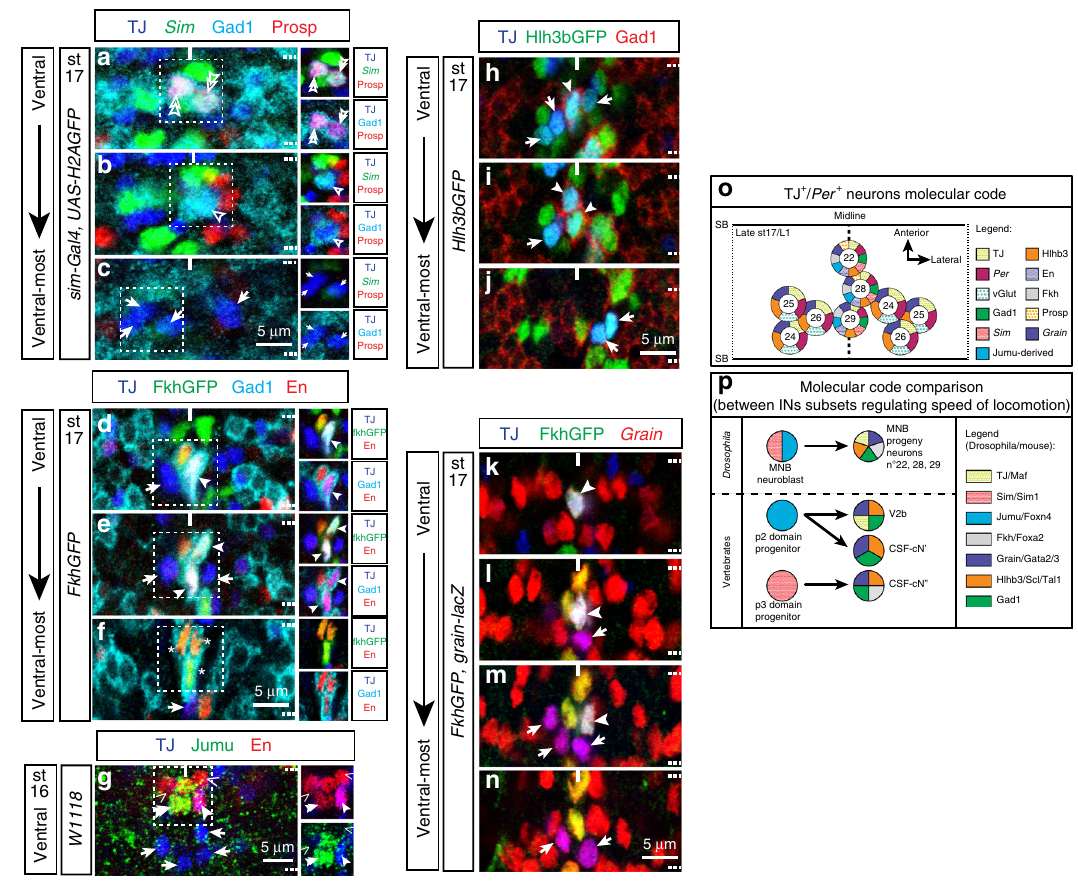
Fig. 9 Molecular characterization of the three TJ + / Per + GABAergic neurons. a – c Staining for TJ (blue), Gad1 (cyan), Prospero (Prosp, red), and GFP (green) driven by sim-Gal4 in late stage 17 embryonic VNC. a , b sim-Gal4 (green) is weakly expressed in ventral TJ + GABAergic + neurons, identifying them as midline cells (simple and double empty arrowheads). c TJ + GABAergic − ventral-most neurons (which are TJ + glutamatergic neurons, pointed by arrows) are sim-Gal4 − , hence not part of the midline cells. Among the three TJ + / sim + weak /GABAergic + located at the midline, two are positive for Prospero ( a double empty arrowheads) and one negative ( b simple empty arrowhead). d – f Staining for TJ (blue), Gad1 (cyan), Engrailed (En, red), and FkhGFP in stage 17 embryonic VNC. Ventrally, TJ + /GABAergic + neurons (full arrowheads) are En + and Fkh + , two markers of MNB progeny neurons. Note in the ventral-most part of the VNC the three iVUMs cells En + /Fkh + /Gad1 + that are TJ − (asterisks in panel f ). g Staining for TJ (blue), Jumu (green), and En (red) in stage 16 embryonic VNC. The MNB neuroblast, identi fi ed by its position and size, is Jumu + (double full arrowhead). Note the presence of En + /TJ − (chevrons) and En + /TJ + MNB progeny neuron (full arrowhead) located in close proximity to the MNB neuroblast. Some TJ + /En − cells located away from the MNB neuroblast can be visualized (arrows). h – j Staining for TJ (blue), Gad1 (red), and Hlh3bGFP (green) in late stage 17 embryo VNC. Both TJ + /GABAergic + (full arrowhead) and TJ + /GABAergic − (arrows) are Hlh3b + . k – n Staining for TJ (blue), FkhGFP (green), and β gal (red) from Grain-lacZ in stage 17 embryonic VNC. Both TJ + /GABAergic + (full arrowhead) and TJ + /GABAergic − (arrows) neurons are Grain + . o Schematic representation of the molecular code for TJ + / Per + neurons in late stage 17 embryo/L1 larva. A full segment is shown; SB indicates segment boundary. p Comparison of the molecular codes found in TJ + MNB progeny neurons and the MNB neuroblast with the code found in the V2b interneurons, CSF-cNs and their progenitors. Transcription factor codes in vertebrates is based on the recent work of Andrzejczuket al. 44 and Petracca et al.